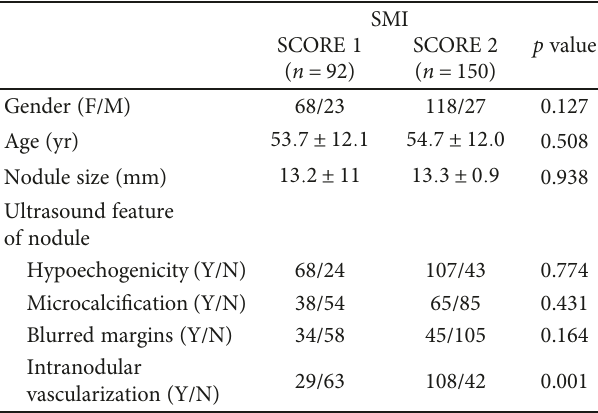
Table 2: Demographic and ultrasound characteristics between patients of SMI score 1 and score 2 cohorts.